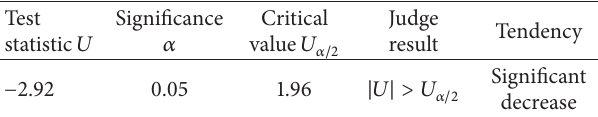
Table 1: Tendency of the runoff series of years by Mann-Kendall statistical